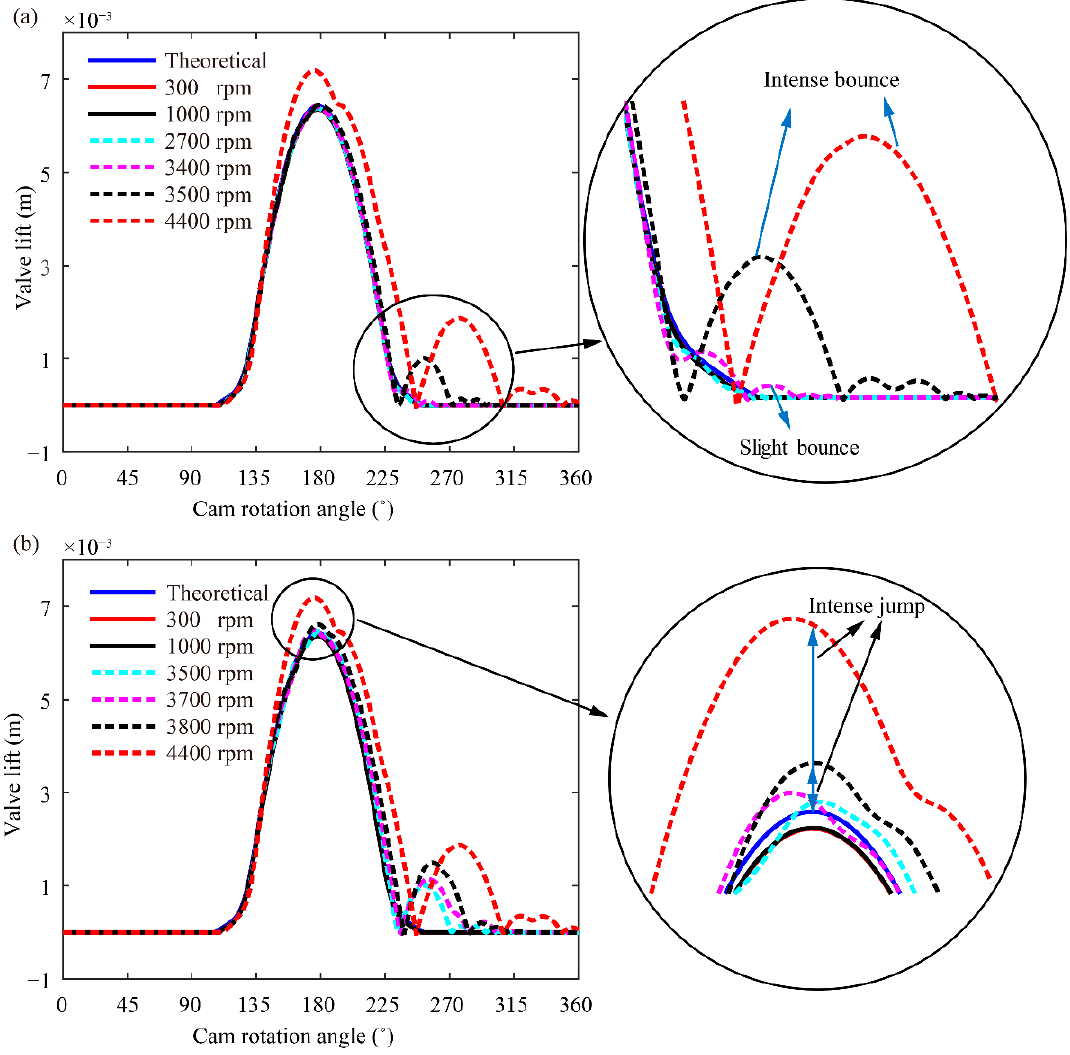
Figure 7. Bounce and jump at different cam rotation speeds: ( a ) bounce and ( b ) jump. In general, the dynamic valve lift predicted by the flexible model should be lower than the theoretical dynamic valve lift because of elastic deformation (at 300 and 1000 rpm in Figure 7b). Valve jump occurs when the cam rotation speed is increased to 3500 rpm because of the separation between the valve and rocker arm. Slight jump occurs when the cam rotation speed is in the range of 3500–3700 rpm. Intense jump occurs when the cam rotation speed exceeds 3800 rpm. Bounce and jump phenomena at different cam rotation speeds are listed in Table